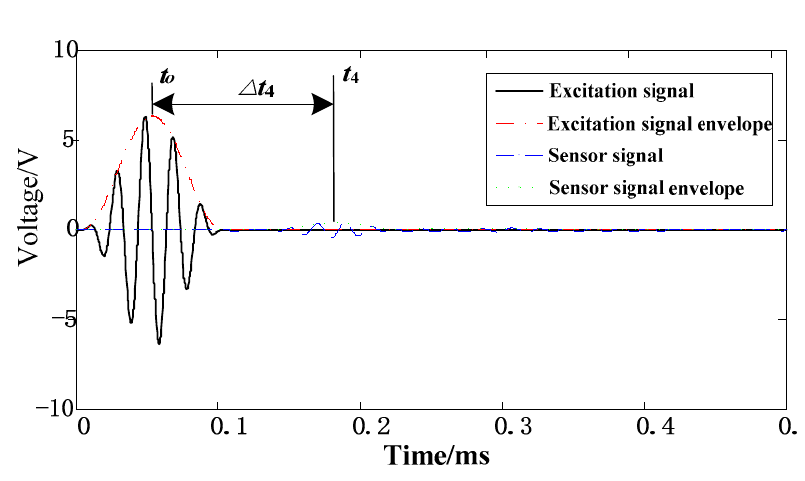
Figure 7. The propagation of the signal in the 90°-direction.